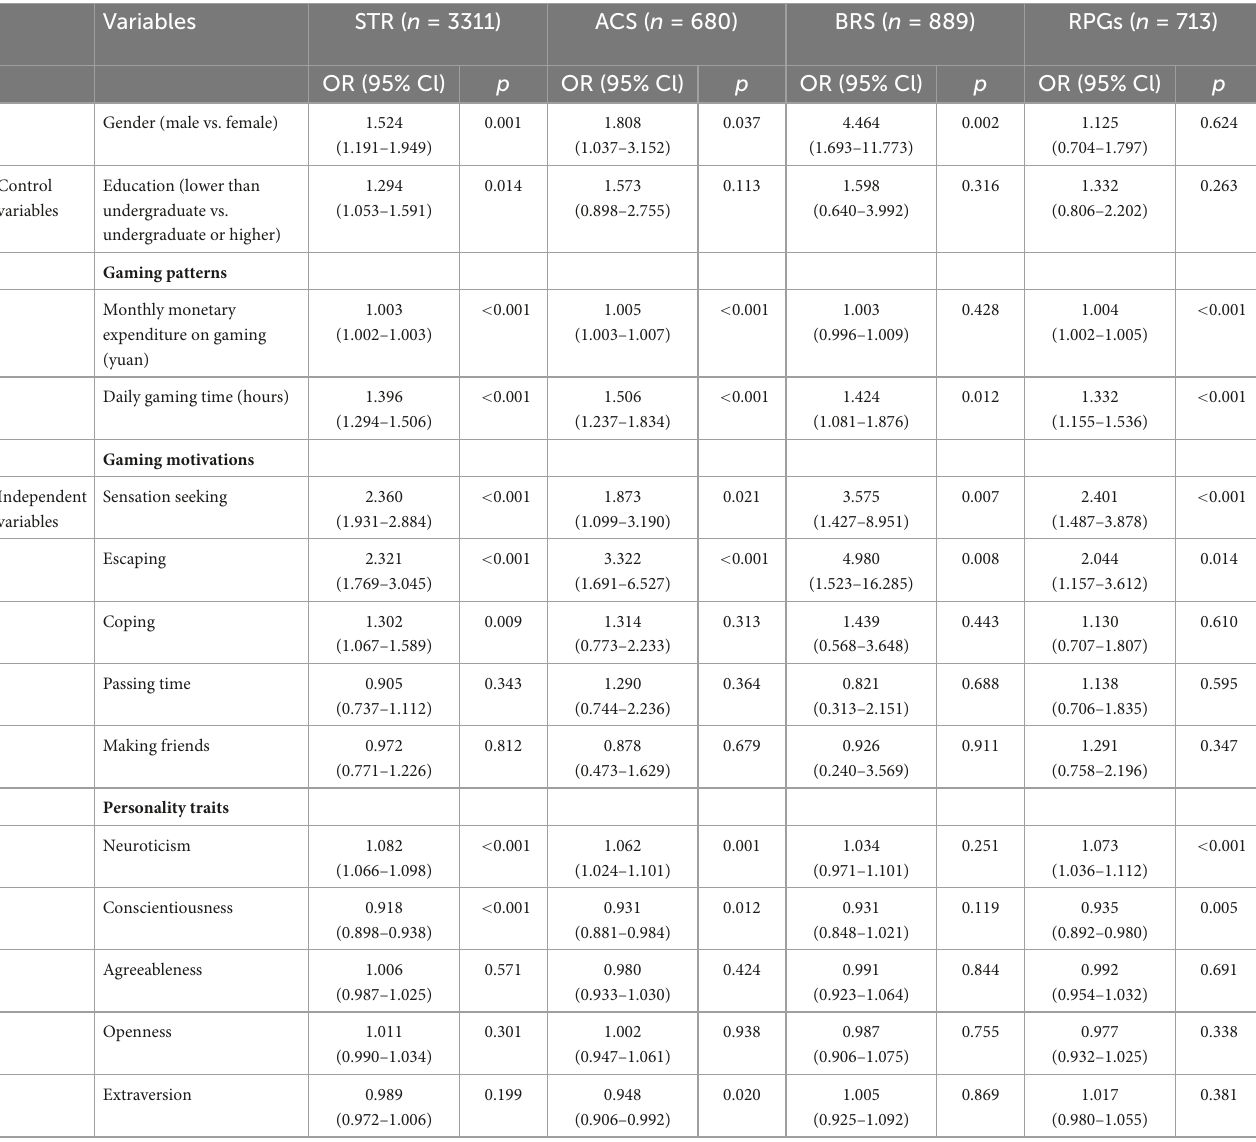
TABLE 3 Binary logistic regression analyses of factors predicting Internet gaming disorder (IGD) in genre-specific groups. Variables